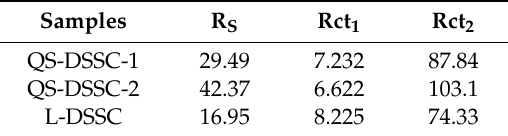
Table 4. The series resistance (R S ) and charge transfer resistance of the Pt / electrolyte interface (Rct 1 ), and the charge transfer resistance of the TiO 2 / electrolyte interface (Rct 2 ) in DSSCs using three types of